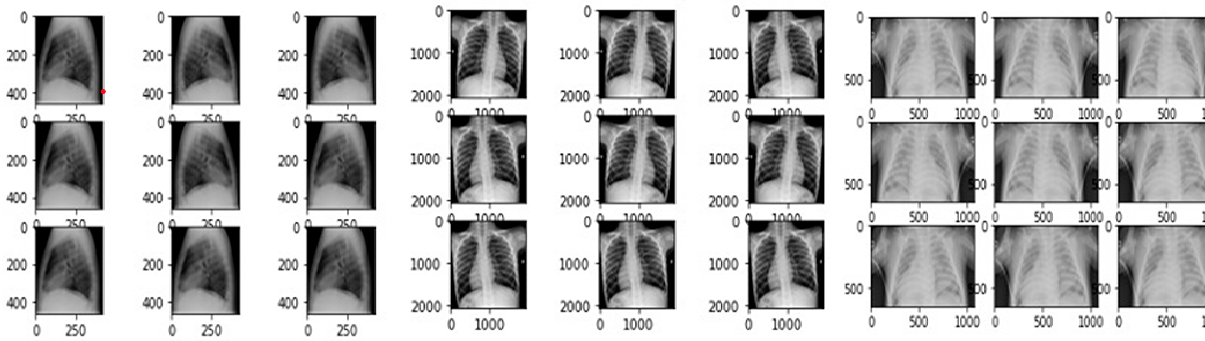
Figure 5. State of images after flip augmentation.